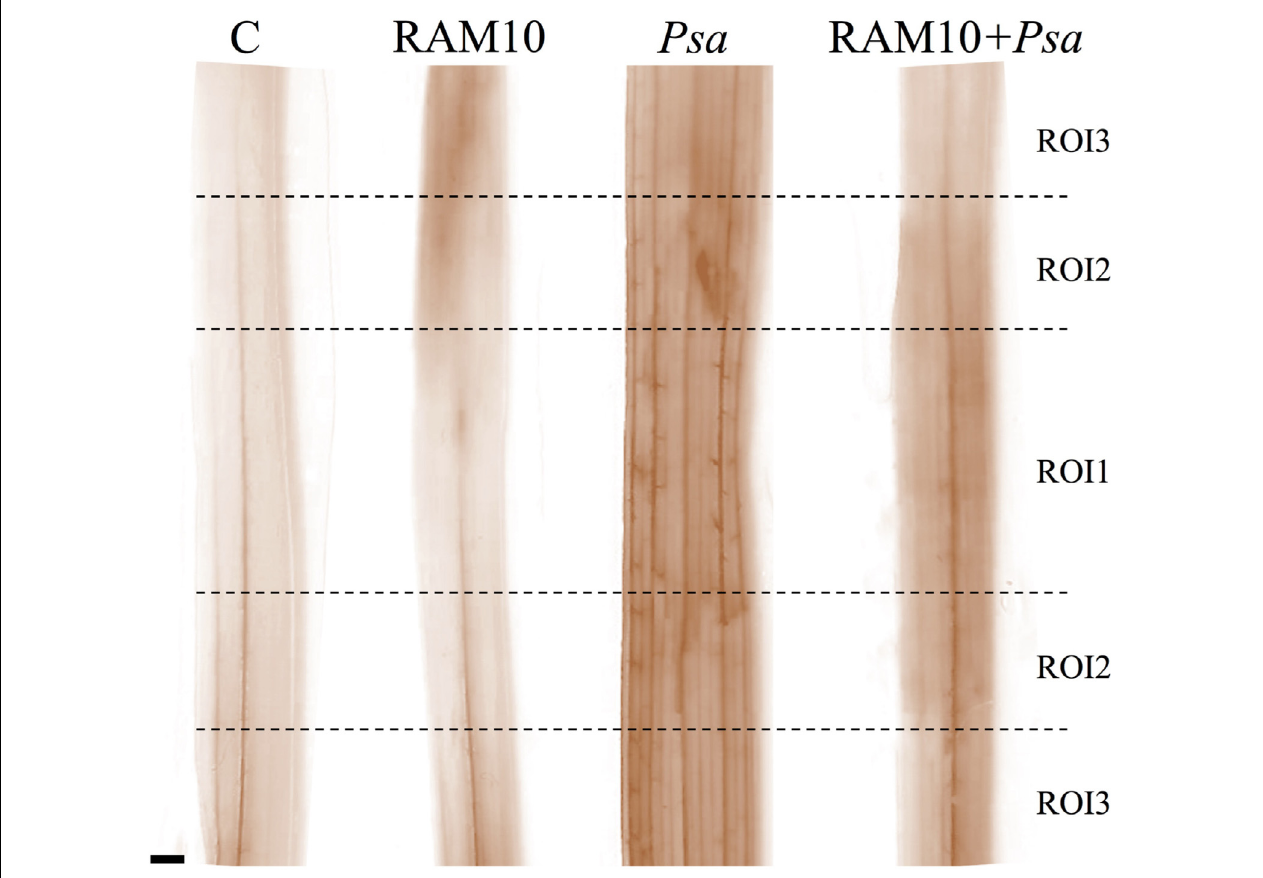
FIGURE 3 | Digitalized DAB-treated leaves 3 h post- Psa inoculation and after application of the color deconvolution plugin. These images were used for subsequent ROI selection, measure of average DAB intensity and H 2 O 2 quantification through the calibration curve appropriate to the range of DAB intensity values; scale bar = 1